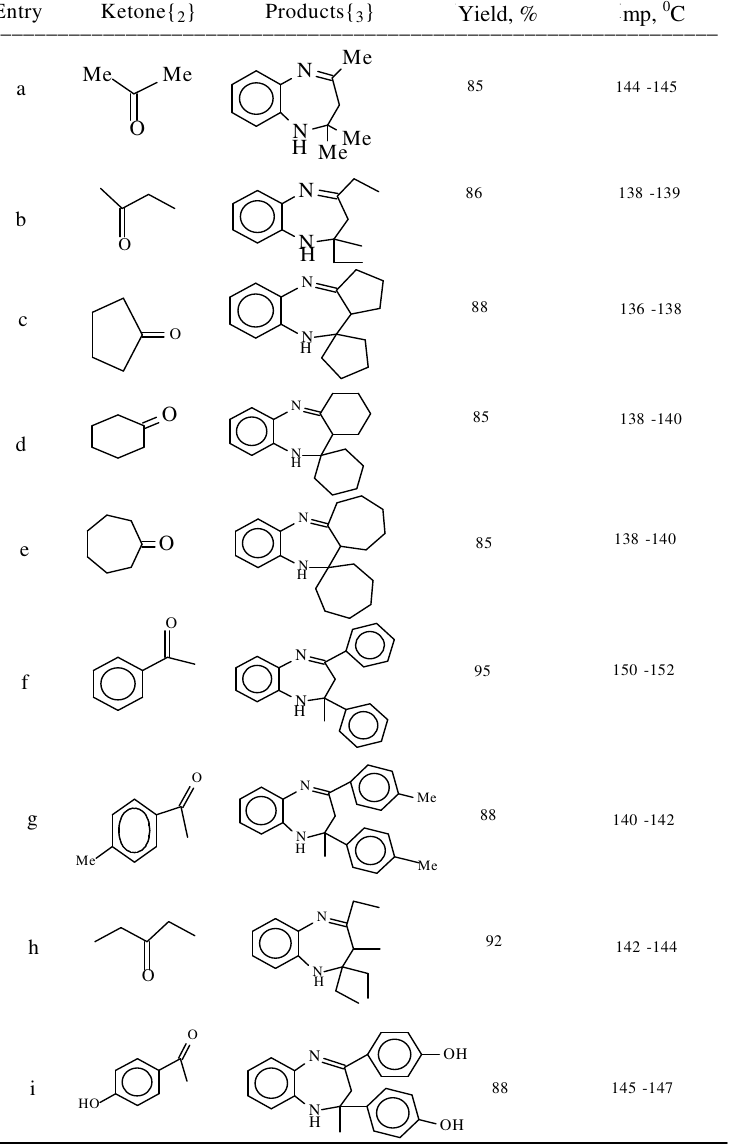
Table 1. TBAB-catalyzed synthesis of 1, 5-benzodiazepines under mild